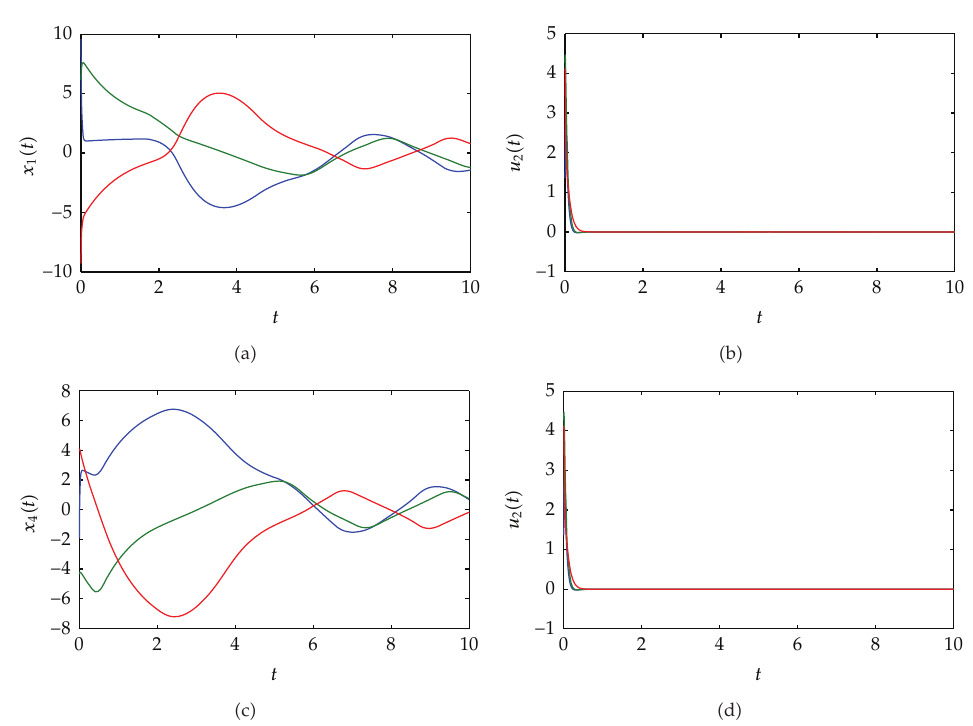
Figure 7: (cid:6) a (cid:7) The trajectory of x 1 in a nonlinearly coupled Hopfield neural network without pinning control. (cid:6) b (cid:7) The signal added on x 1 in the above Hopfield neural network. (cid:6) c (cid:7) The trajectory of x 4 in a nonlinearly coupled Hopfield neural network without pinning control. (cid:6) d (cid:7) The signal added on x 4 in the above Hopfield neural